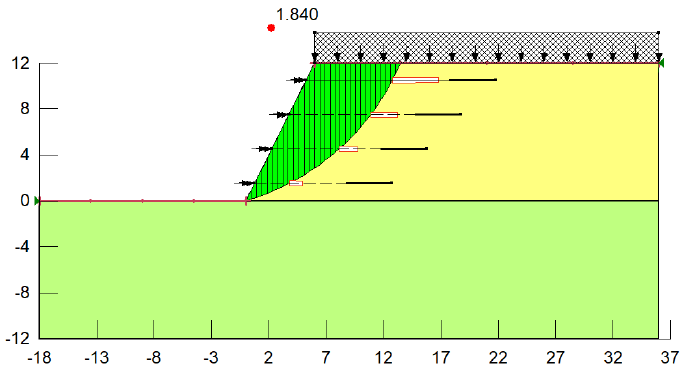
Figure 21. Example 1 calculation results of the stability of Geo.